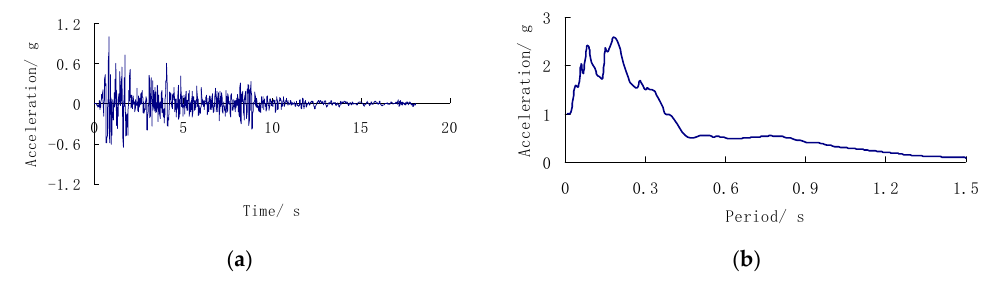
Figure 5. Achieved table motion. ( a ) Time history; ( b ) Response spectrum.